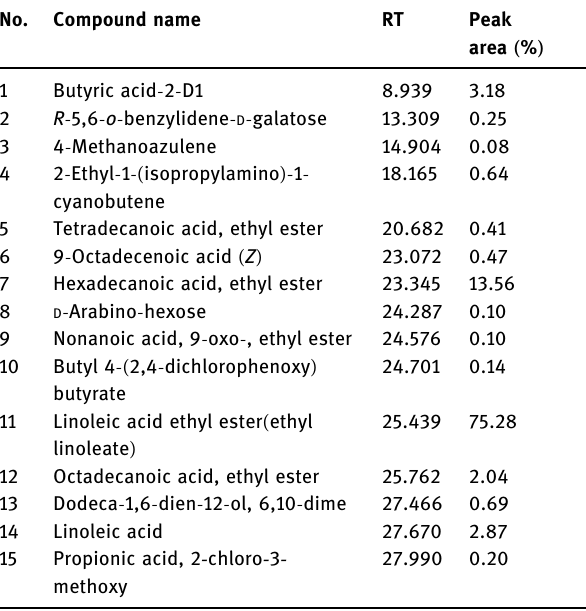
Table 1: GC - MS analysis of N. sativa seed extract No. Compound